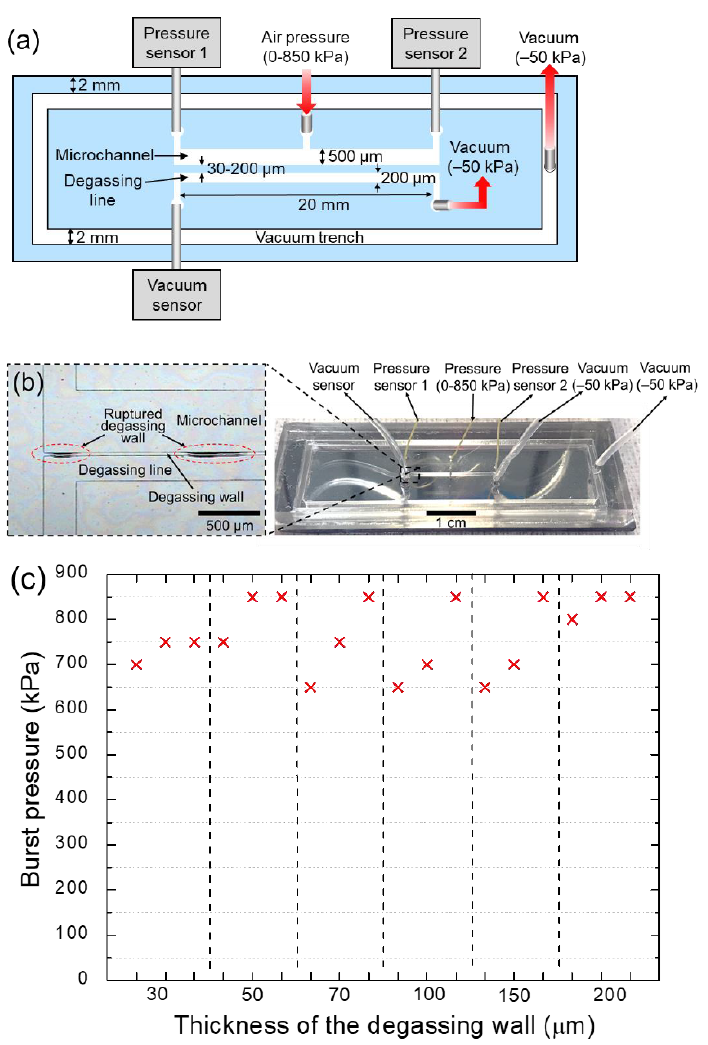
Figure 4. ( a ) Illustration of the instrumental setup for the burst test of the degassing wall. ( b ) Photograph of the disposable lateral degassing device for burst test of the degassing wall and enlarged view of the ruptured degassing wall. ( c ) Burst pressure measured according to the thickness of the degassing wall. The measurements were performed three times for each thickness of the degassing